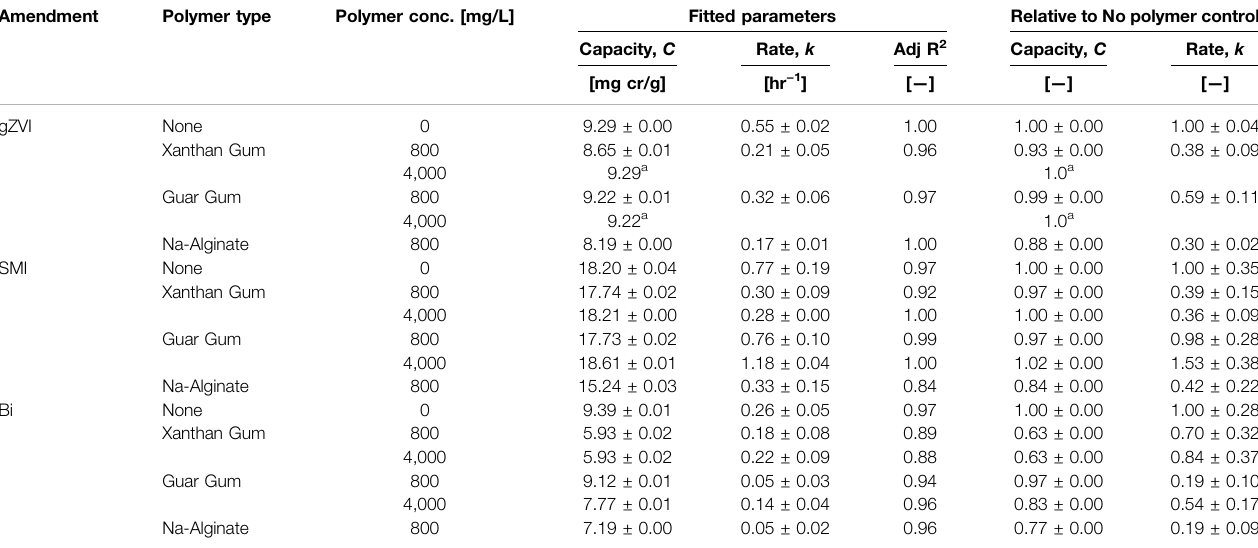
TABLE 2 | K 2 CrO 4 removal via solid phase amendments (kinetics and